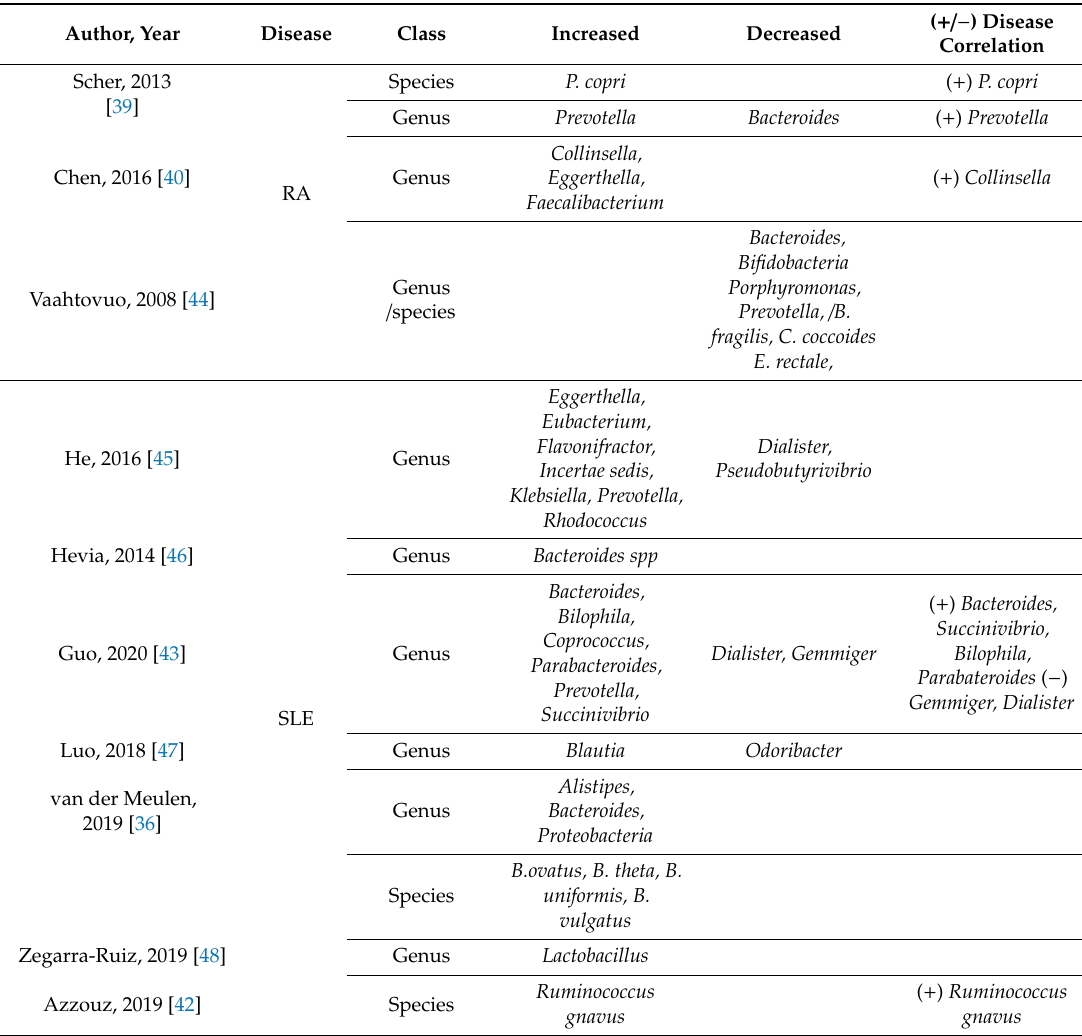
Table 1. Human studies of rheumatoid arthritis and systemic lupus erythematosus showing gut dysbiosis detected by metagenomic